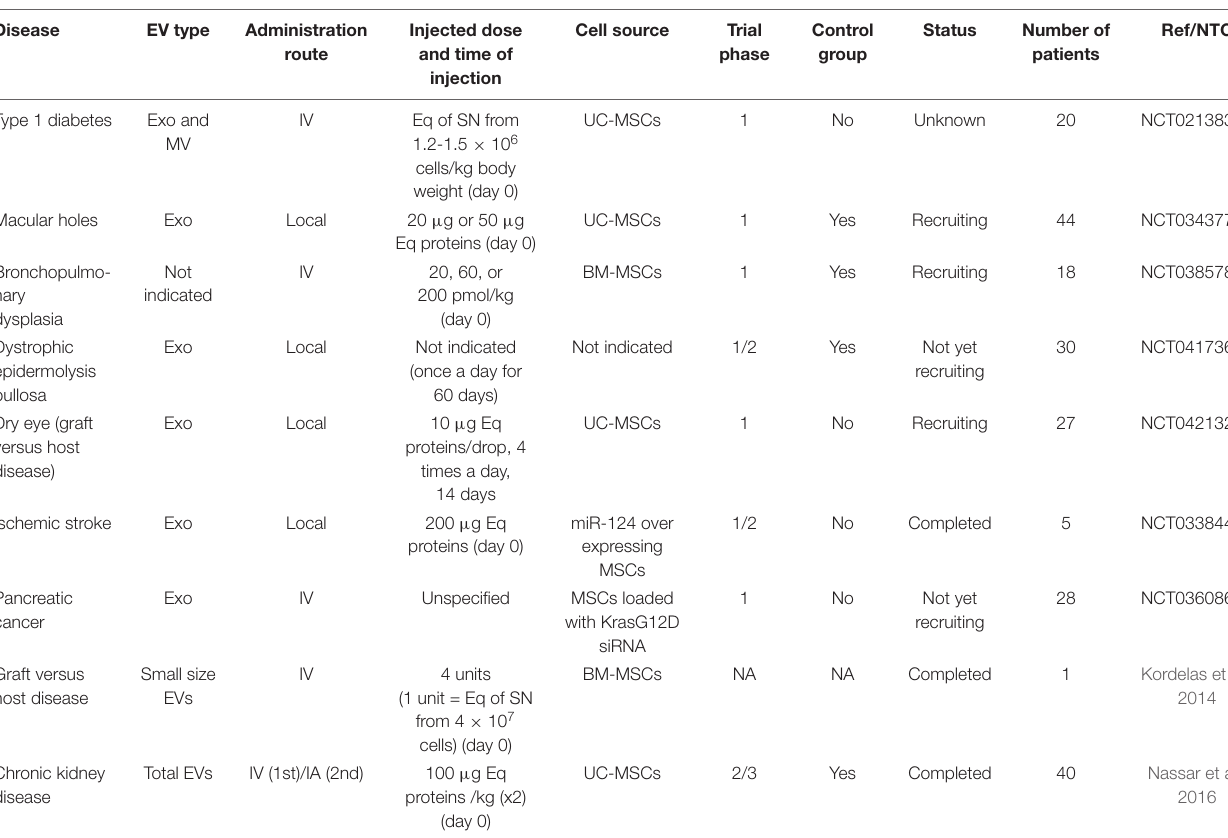
TABLE 1 | Clinical trials evaluating MSC-EV therapies.